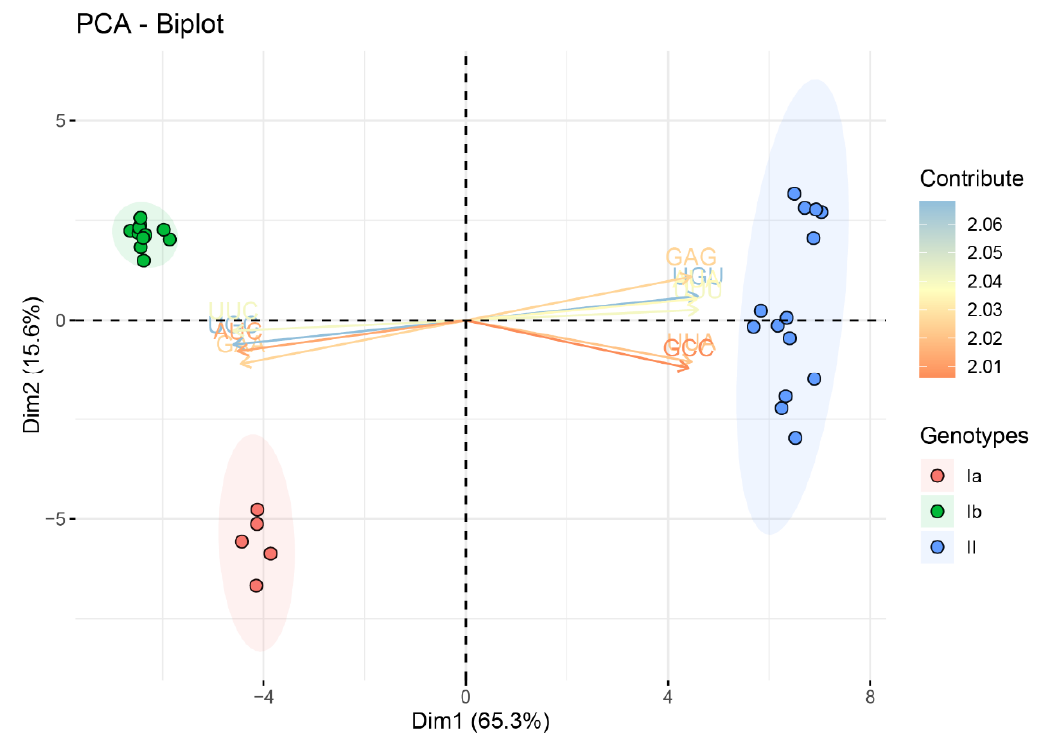
Figure 2. Principal components analysis (PCA) based on the RSCU values of the TGEV complete coding sequences. The significant separation in codon usage bias between the three genotypes of TGEV was present. Genotypes Ia, Ib, and II are represented in orange, green, and blue, respectively.